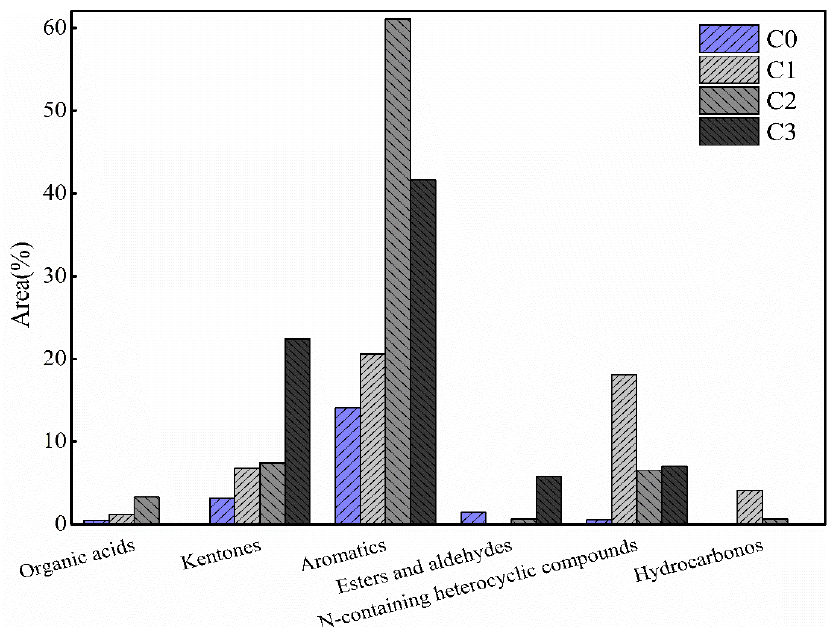
Figure 4. Compound composition of Bio-crude oil.